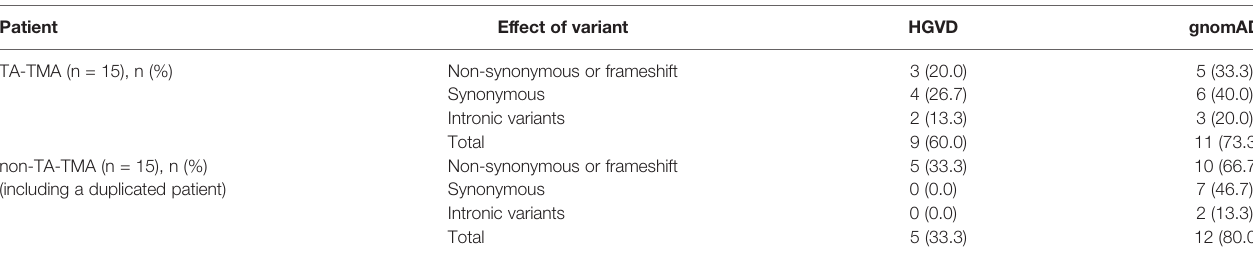
TABLE 2 | Proportion of patients with rare variants.